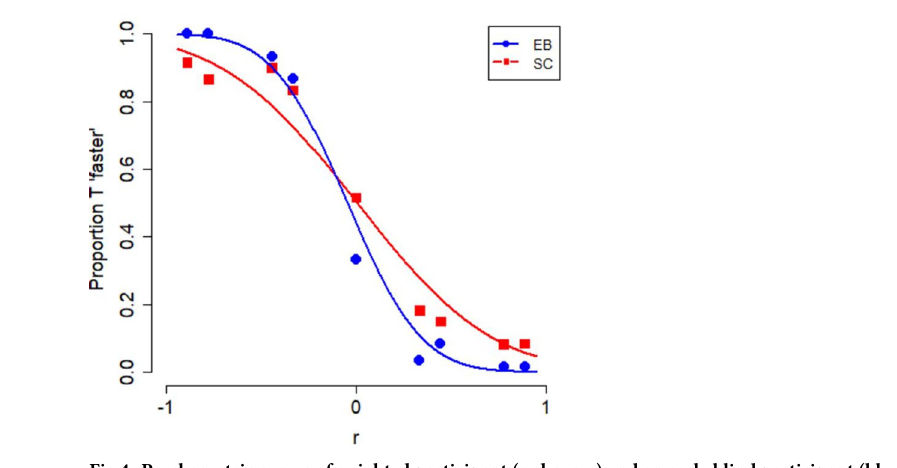
Fig 4. Psychometric curves of a sighted participant (red curve) and an early blind participant (blue curve): Exemplifications of inverted psychometric curves, fitted to the proportion of “faster” responses on the radial distance (r). Inverted psychometric curves denoted an impediment in performing the speed discrimination task. In this example, the reported psychometric curves refer to the coherent condition.